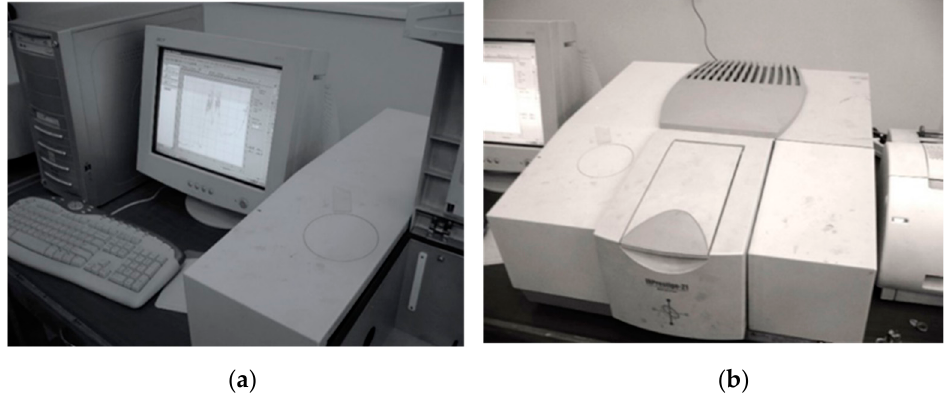
Figure 1. IRPrestige-21, infrared spectrophotometer: ( a ) desktop computer; ( b ) interferometer. The IRPrestige-21 uses a bright ceramic light source (wavenumber measurement range 7500–400 cm − 1 ) (1.33–25 µm), a high-sensitivity DLATGS detector, and high-throughput